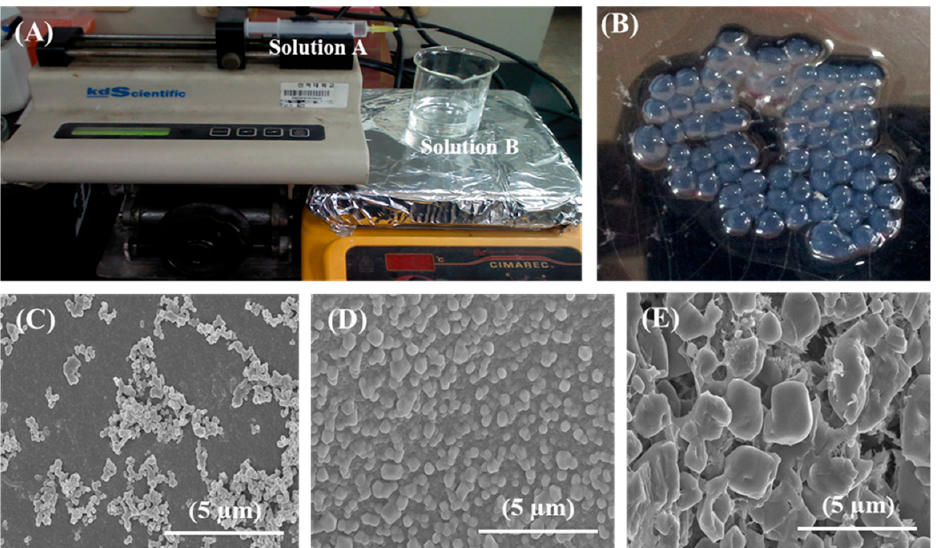
Figure 1. Preparation and structural features of microcapsules: Digital images of ( A ) assembly of preparation and ( B ) prepared G-capsules via the liquid-droplet-forming method. FE-SEM micro- graphs of the surface morphologies of ( C ) G-capsules, ( D ) C-capsules, and ( E ) M-capsules.